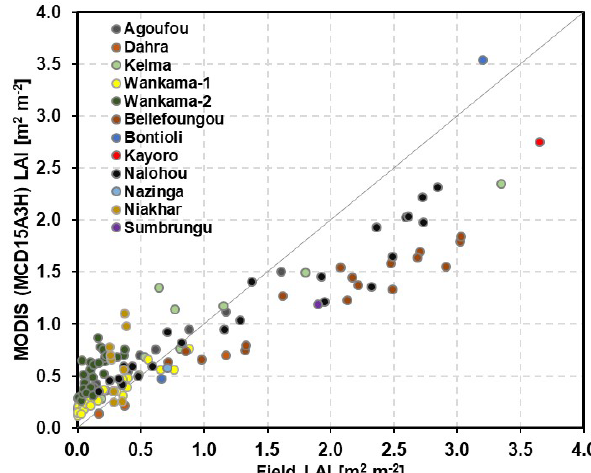
Figure 2. Comparison between field LAI measurements and MODIS (MCD15A3H) LAI estimation at different eddy-covariance